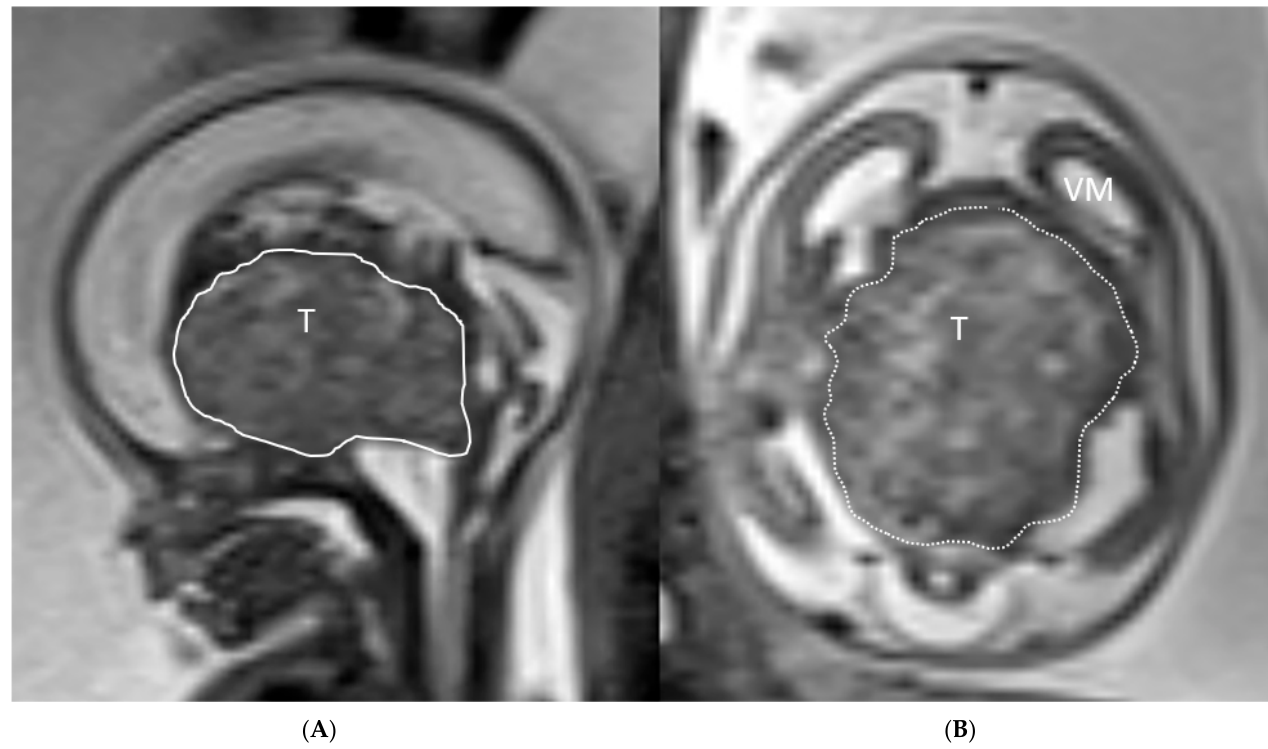
Figure 1. ( A , B ): Ultrafast T2-weighted fetal MR image showing a 3.9 cm suprasellar mixed solid- cystic, suprasellar mass lesion compressing the brainstem (BS), mesencephalon (M) and elevating and compressing the third ventricle with resultant supratentorial ventriculomegaly (VM). Imaging characteristics most compatible with a teratoma (T).